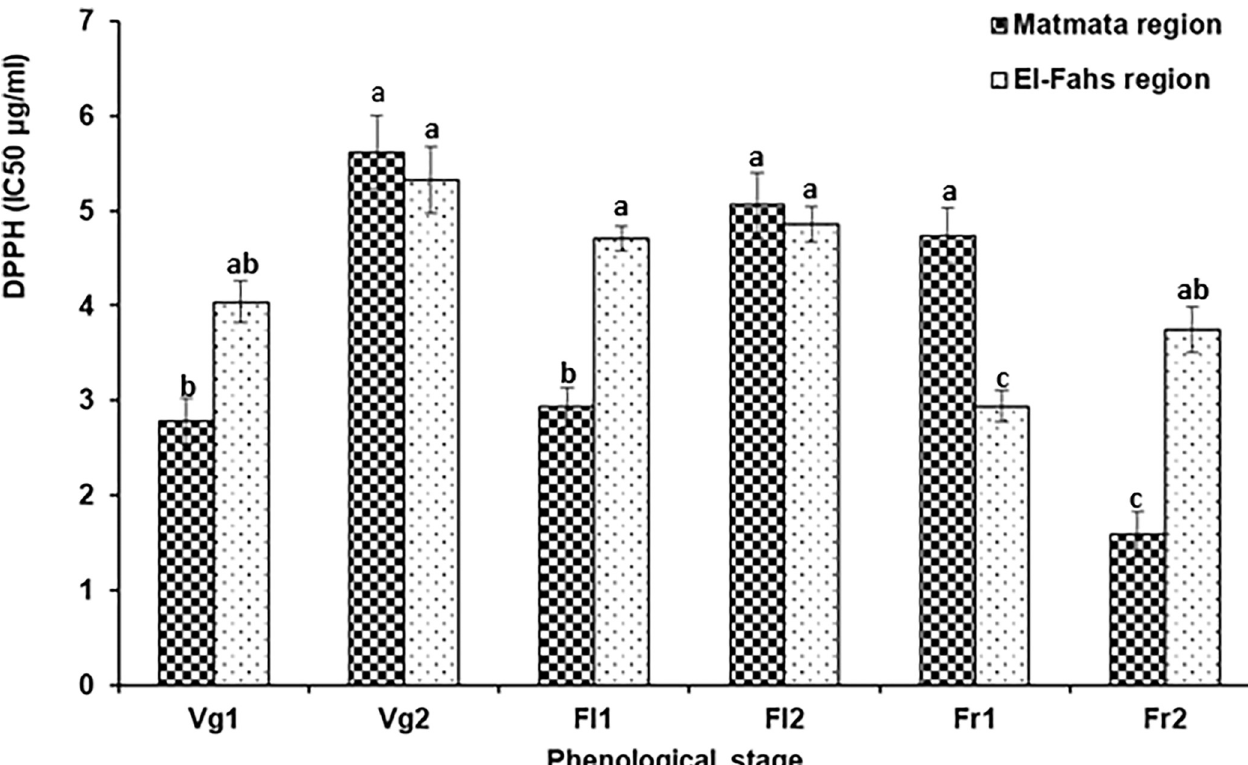
Fig 3. Antioxidant activity of the essential oils of Rosmarinus officinalis